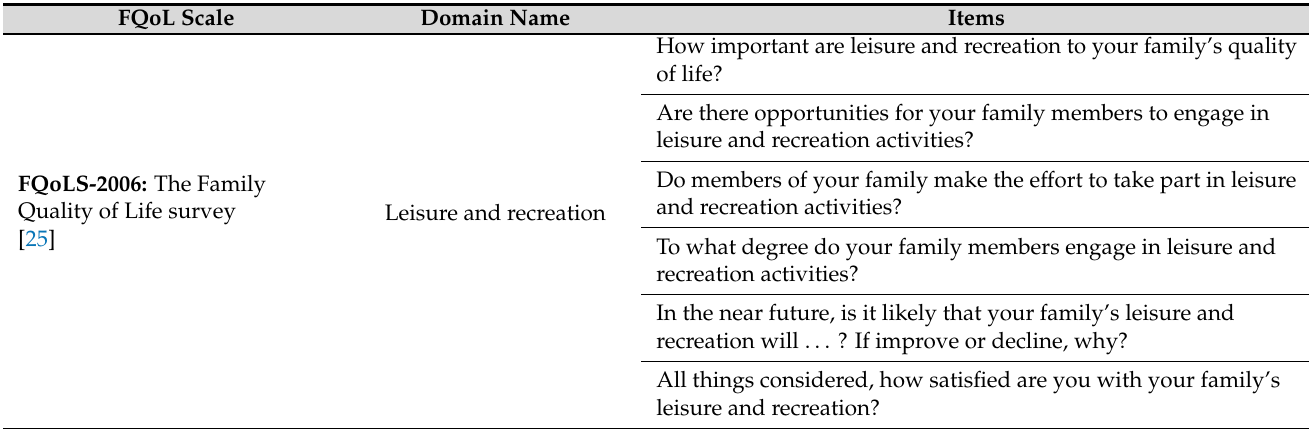
Table 10. Items considered in the domain of leisure/economy and leisure within each FQoL